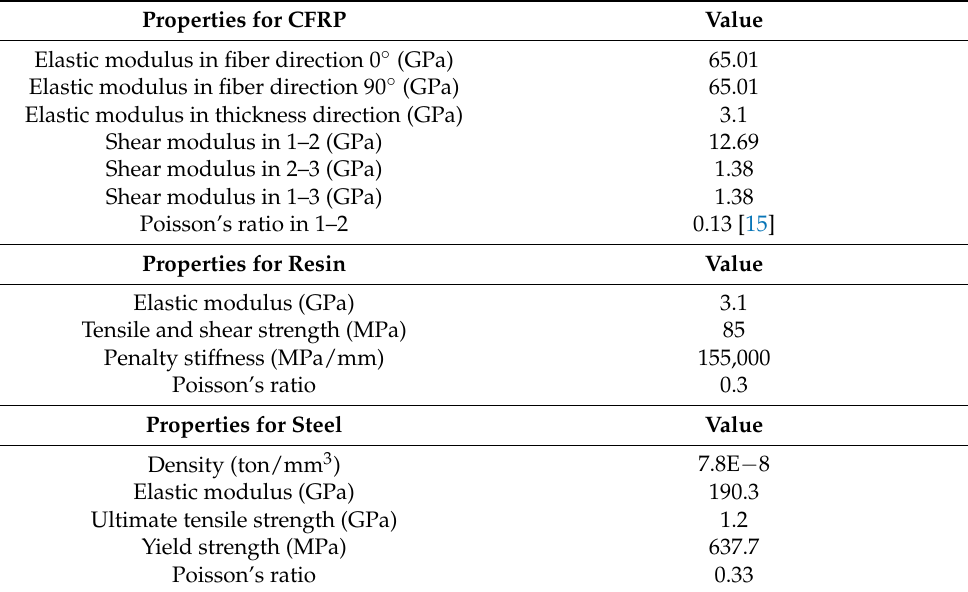
Table 2. The material properties for steel and CFRP used in FE simulation [21].